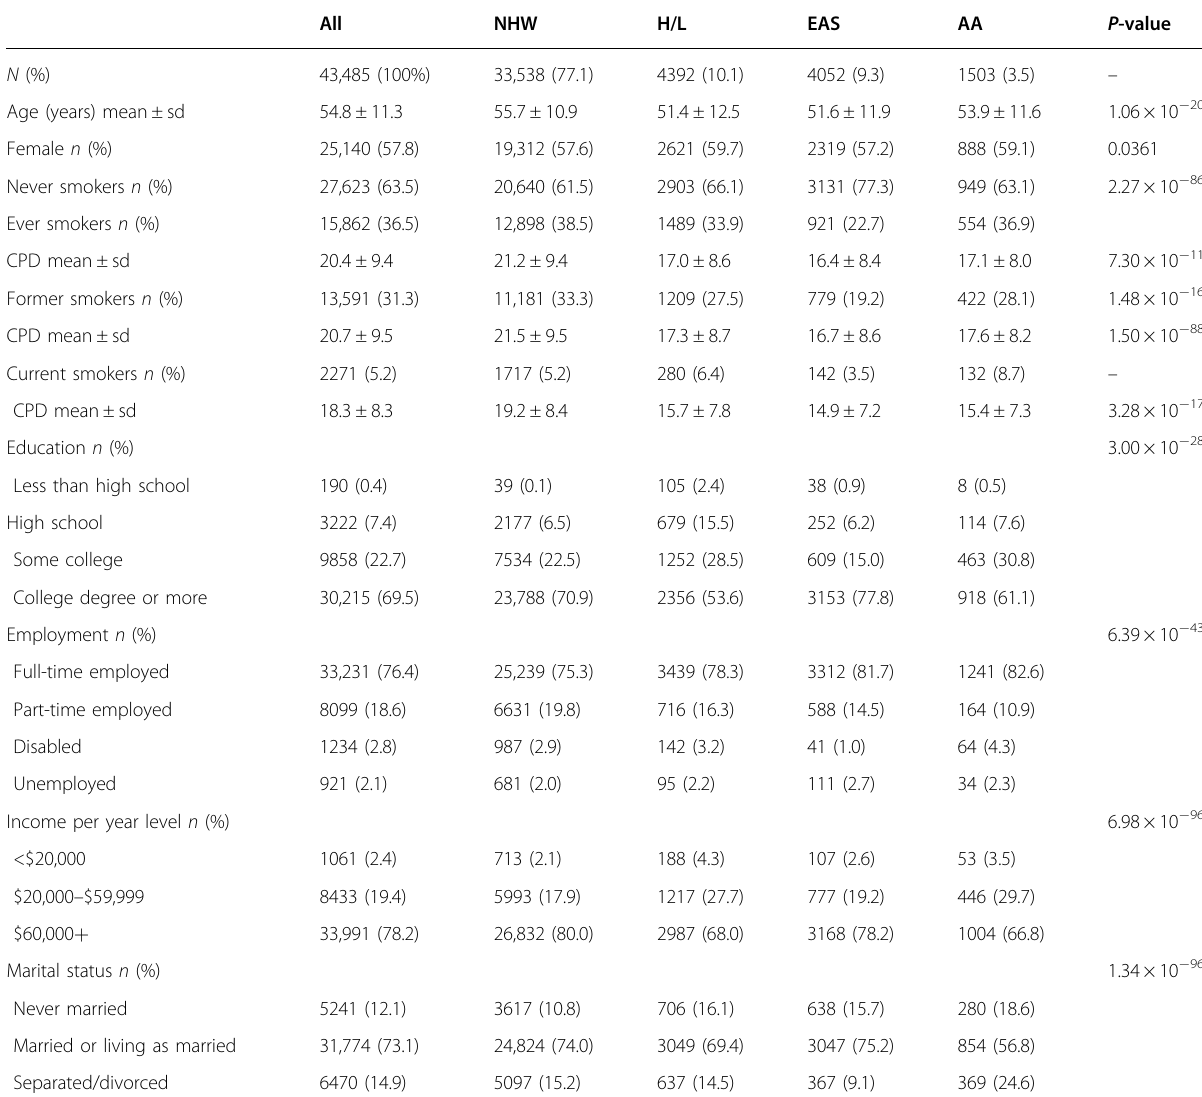
Table 1 Characteristics of the GERA participants included in the current